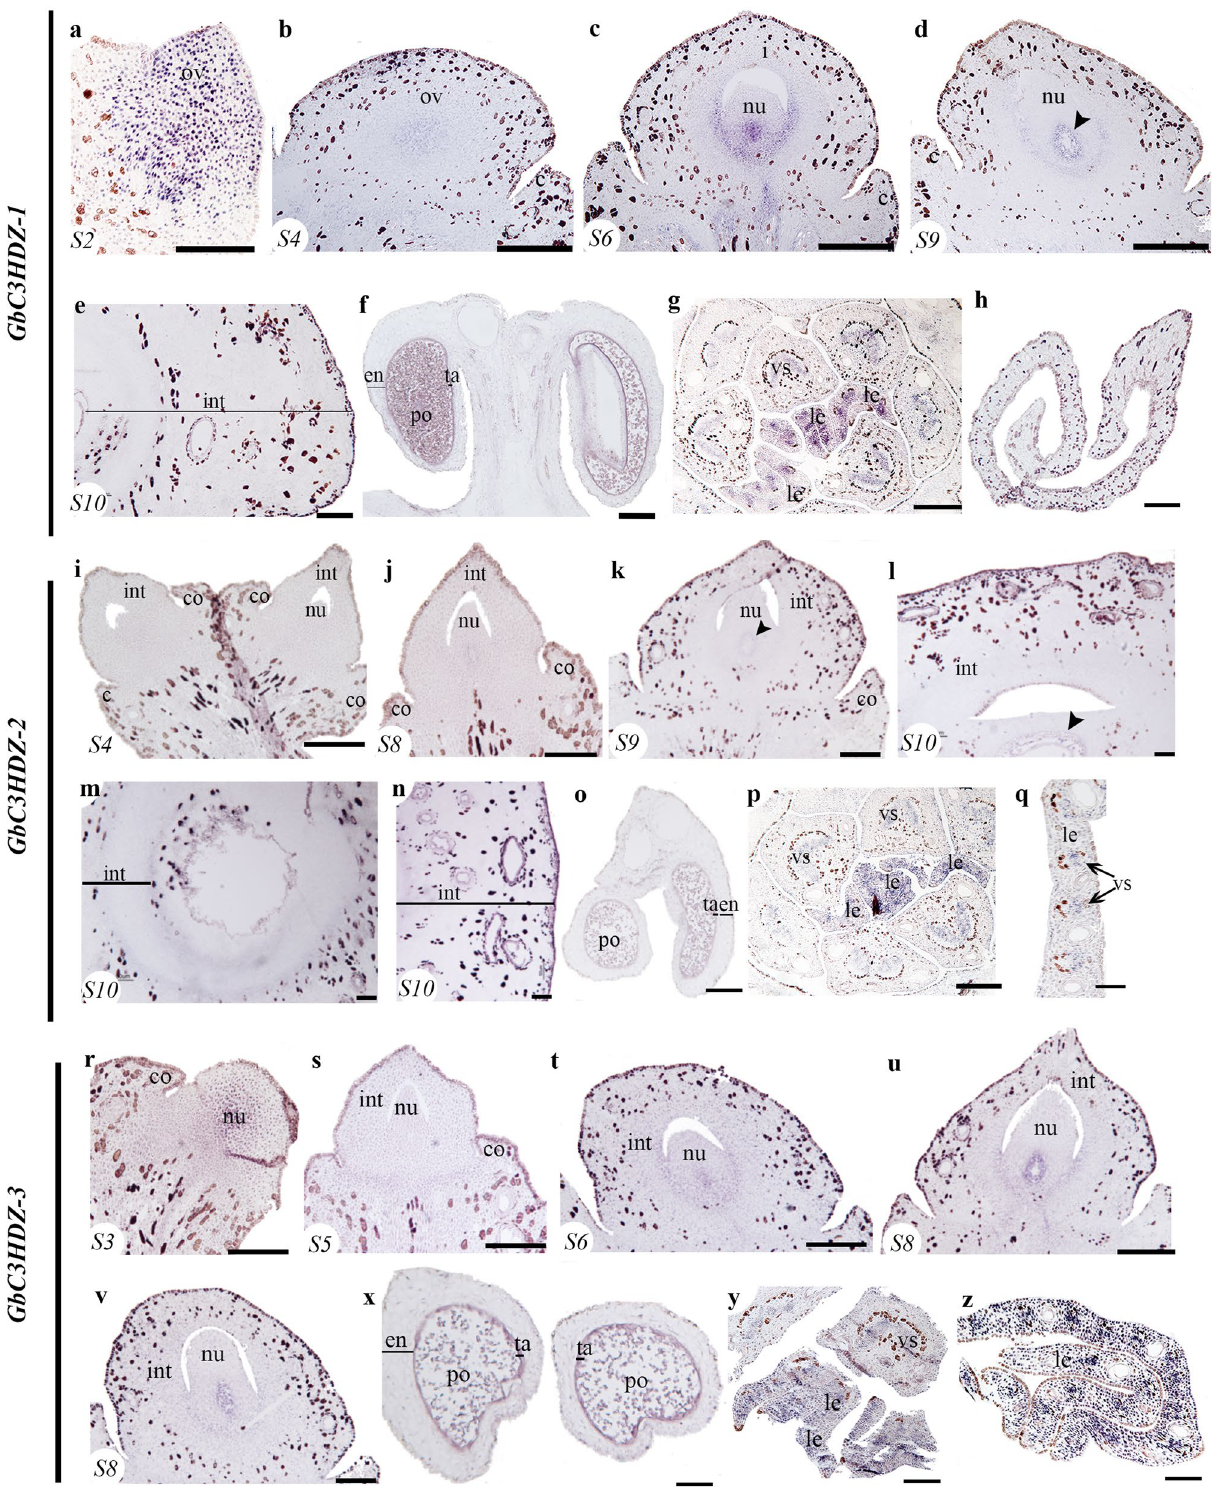
Figure 4. Expression patterns of three C3HDZ s homologues. (a–h) Expression patterns of GbC3HDZ-1 . (a) Ovule in stage 2 (S2). (b) Ovule in stage 4 (S4). (c) Ovule in stage 6 (S6). (d) Ovule in stage 9 (S9). (e) Integument of an ovule in stage 10 (S10). (f) Microsporangium, showing expression in the pollen grains and tapetum. (g) Cross section of a short shoot with leaf primordia in the center. (h) Cross section of a well-developed leaf. (i–q) Expression patterns GbC3HDZ-2. (i) Ovules in stage 4 (S4). (j) Ovule in stage 8 (S8). (k) Ovule in stage 9 (S9). (l,m) Ovule in stage 10 (S10). (o) Microsporangia. (p) Cross section of a short shoot with leaf primordia in the center. (q) Cross section of a well-developed leaf. (r–z) Expression patterns GbC3HDZ-3. (r) Ovule in stage 3 (S3). (s) Ovule in stage 5 (S5). (t) Ovule in stage 6 (S6). (u) Ovule in stage 8 (S8). (v) Ovule in stage 9 (S9). (x) Microsporangia. (y) Cross section of a short shoot with leaf primordia in the center. (z) Cross section of a leaf. Black arrowheads pointing to the megaspore mother cell; co collar, en endothelium, int integument, le leaf, nu nucellus, po pollen, ta tapetum, vs vasculature. Scales: 50 μm ( a,b,i,j,r–t ); 75 μm ( c,e–g,k,p,u,v,y ); 100 μm ( d,h,l–o,q,x,z